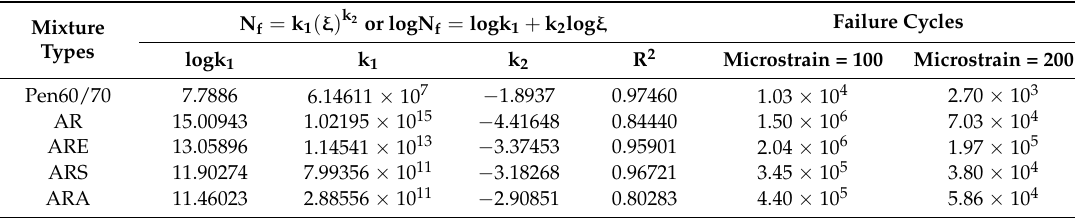
Table 2. Results of the indirect tensile fatigue test